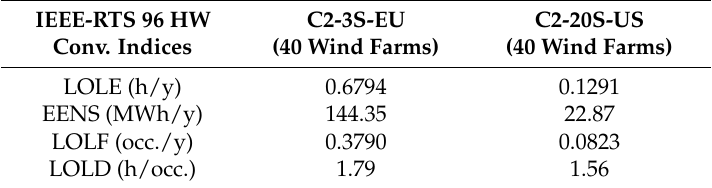
Table 6. Static reserve-IEEE-RTS 96 HW increasing